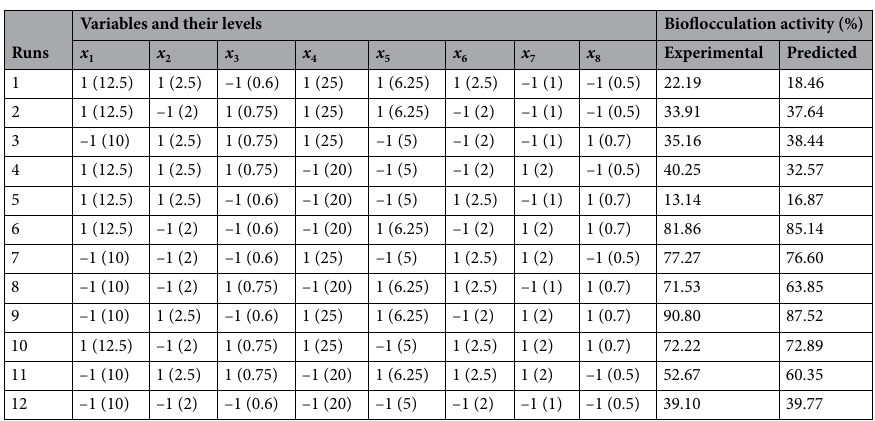
Table 2. Experimental and corresponding results by Plackett–Burman (PB) design for 8 variables.